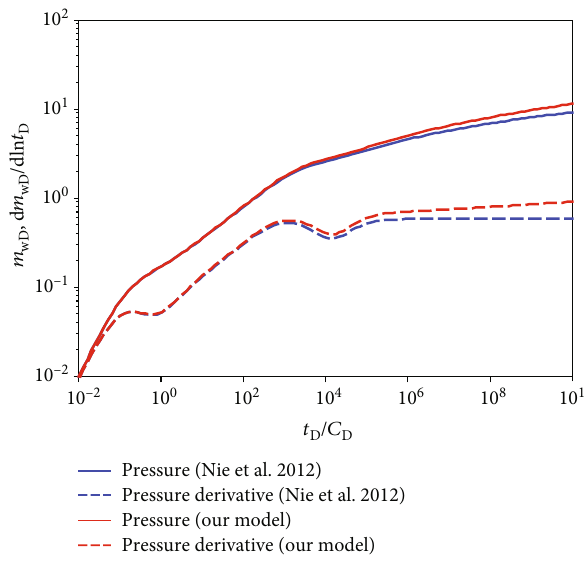
Figure 4: Comparison of the results of the proposed model with that of Nie et al. [25].